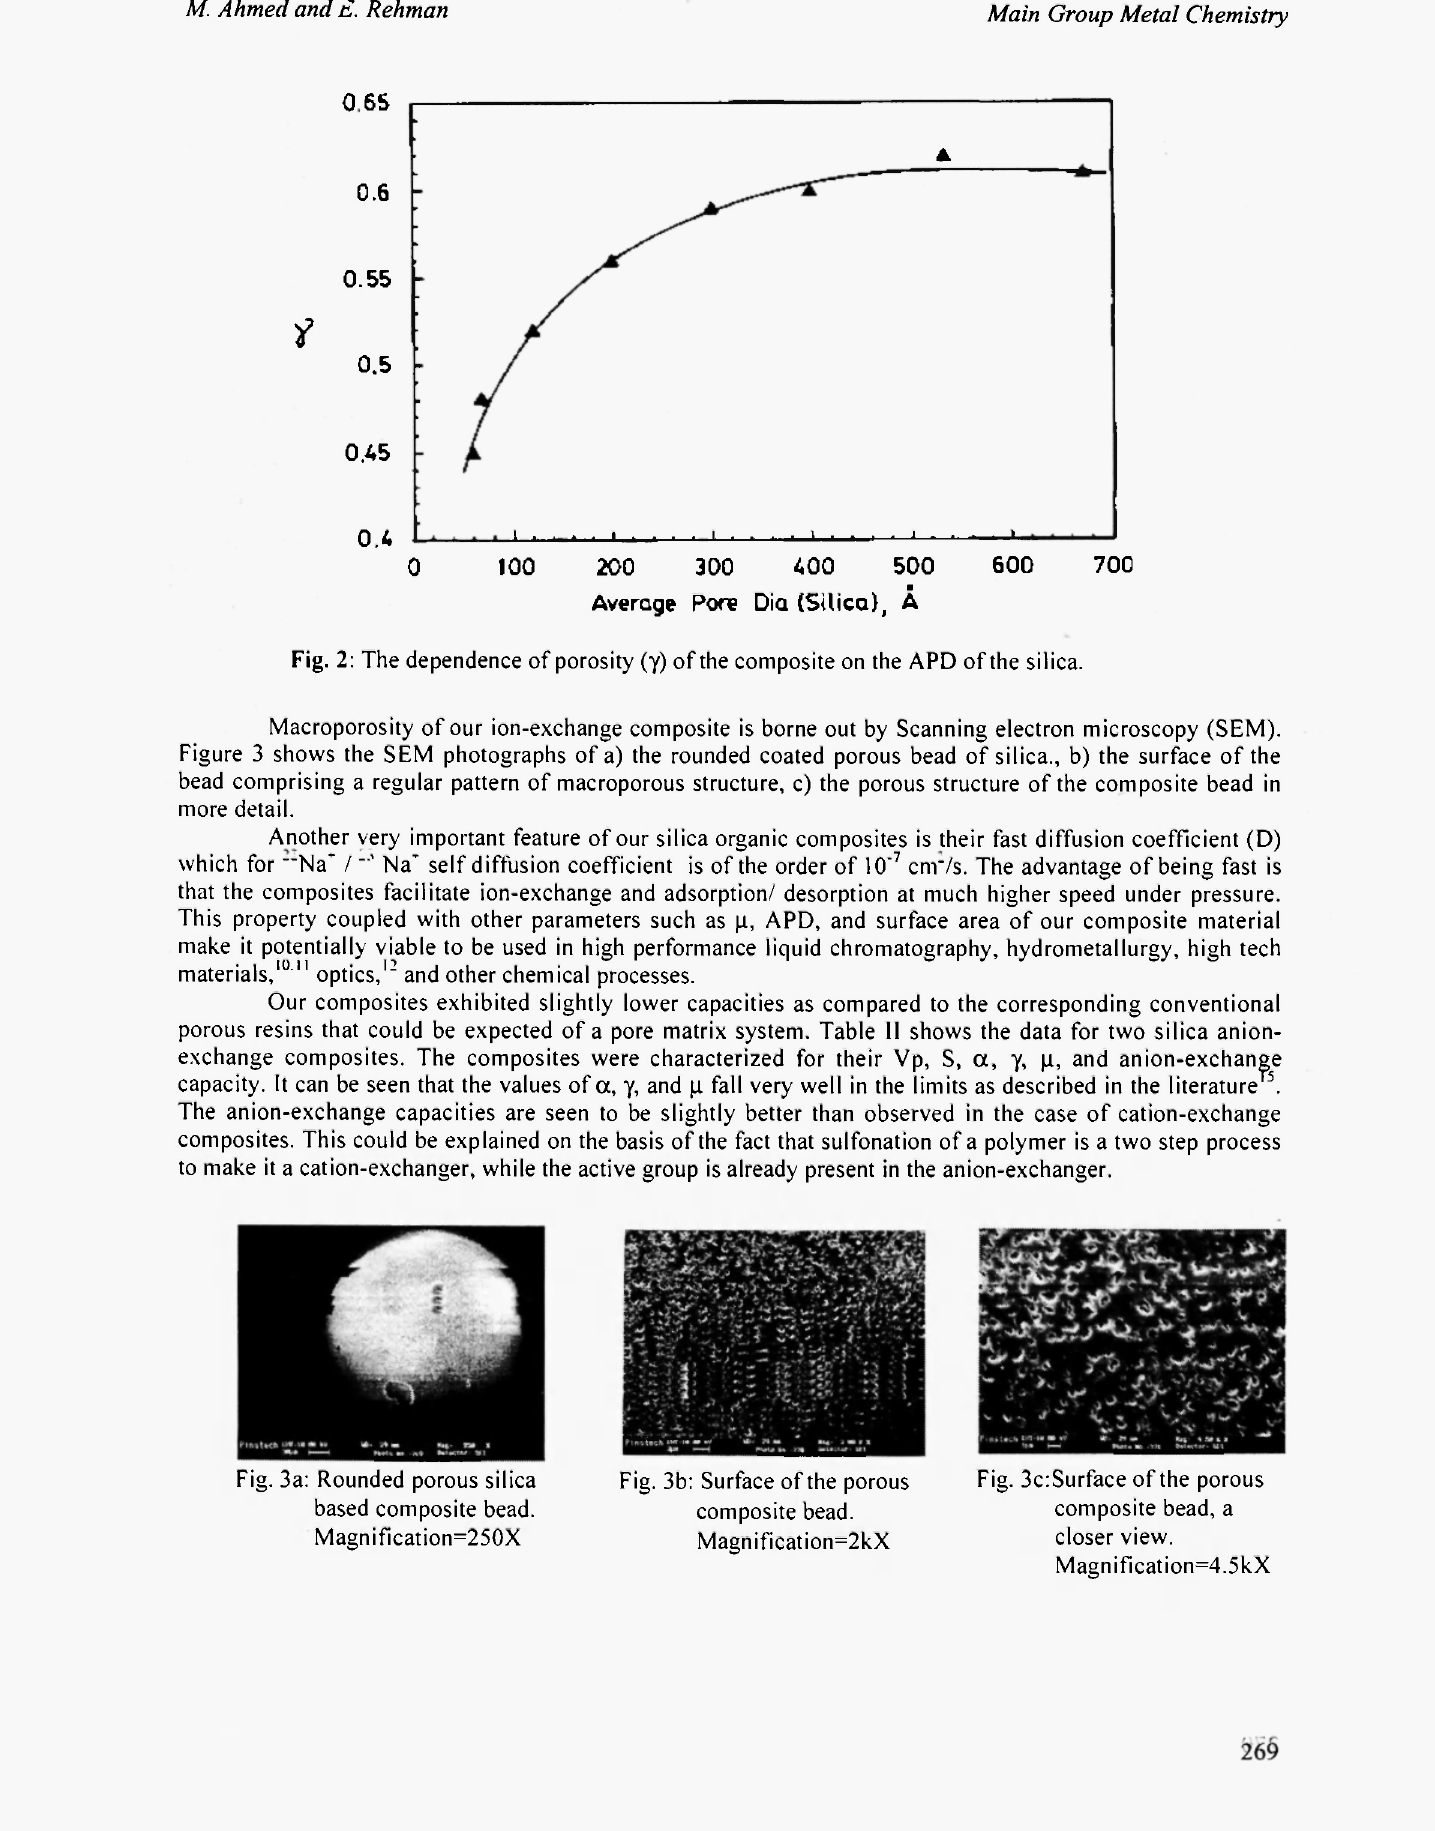
Fig. 3b: Surface of the porous composite bead. Magnification=2kX